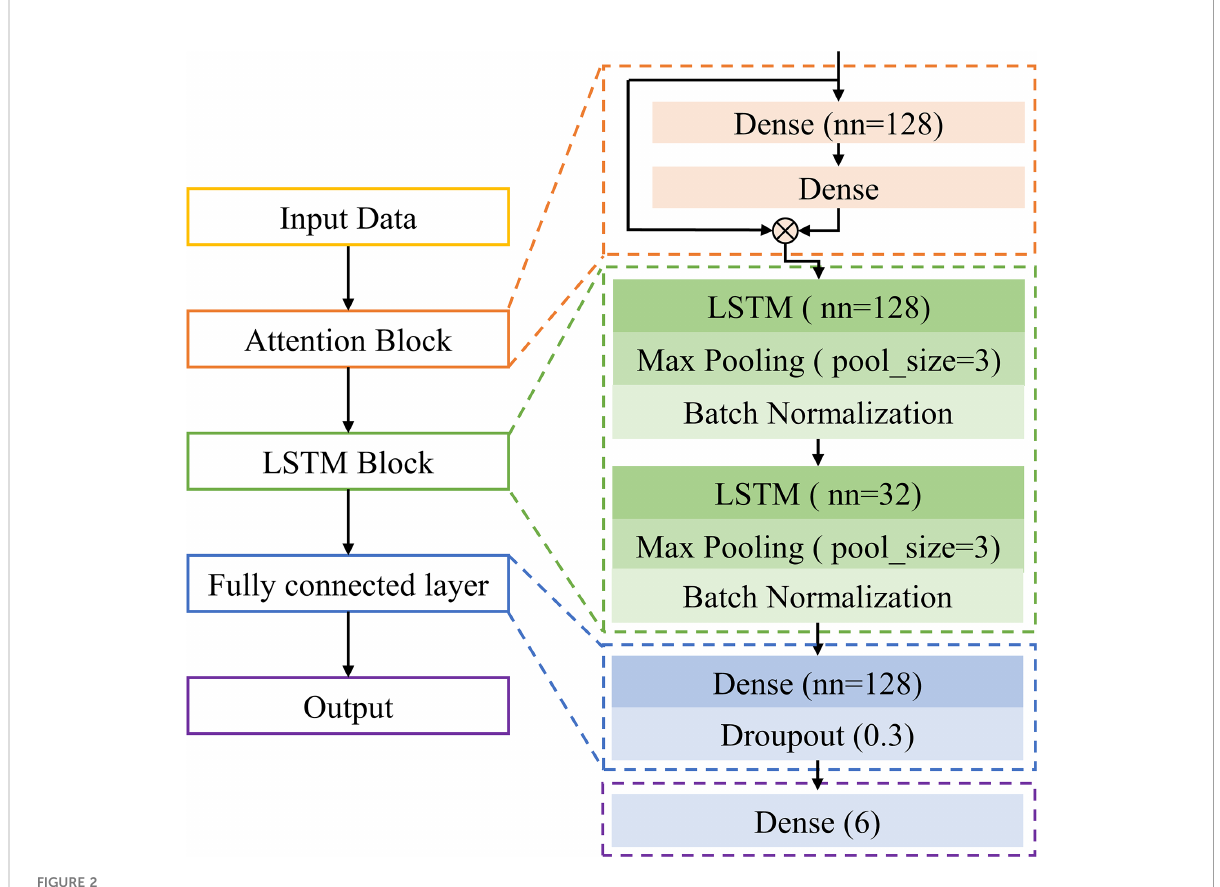
FIGURE 2 The architecture of ATT-LSTM